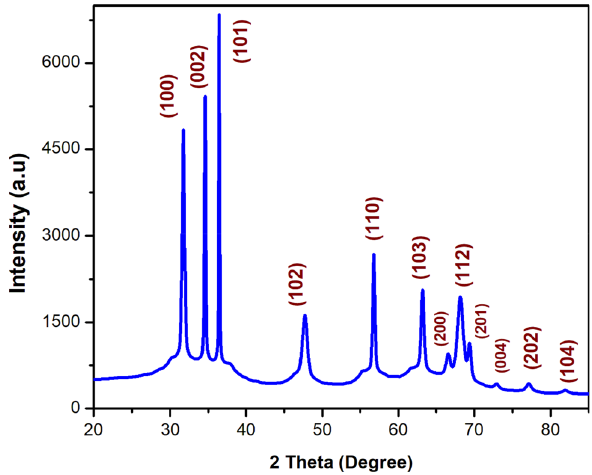
Fig. 7 Powder XRD of ZnO NPs using leaf extract of Becium gran- diflorum